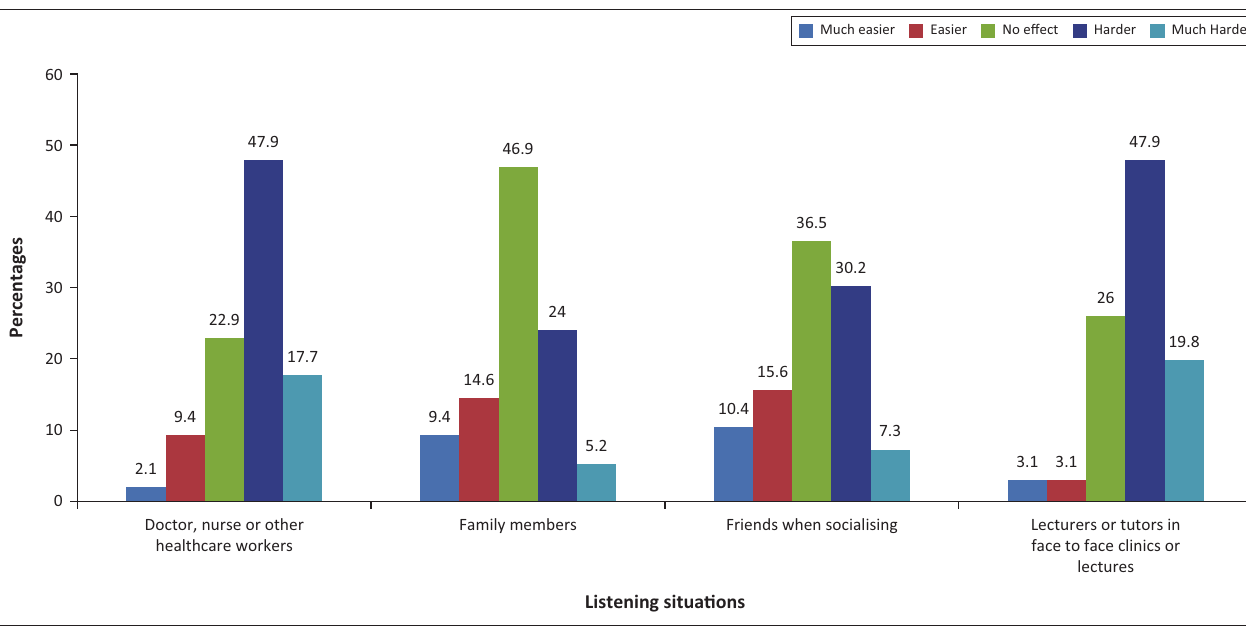
FIGURE 5: Difficulties in feeling connected and engaged with face masks being worn ( n =